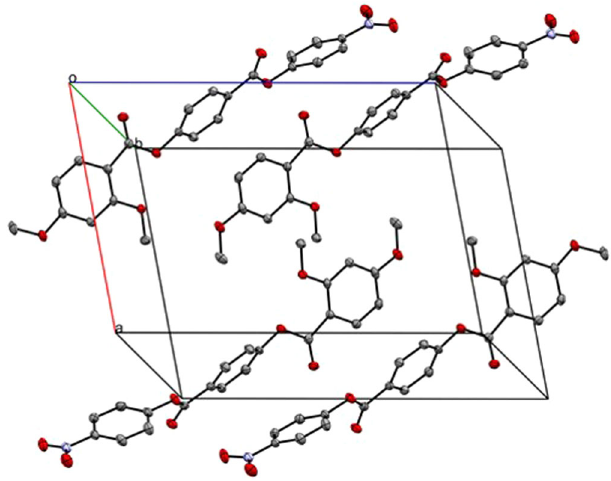
¯1 space group) displayed